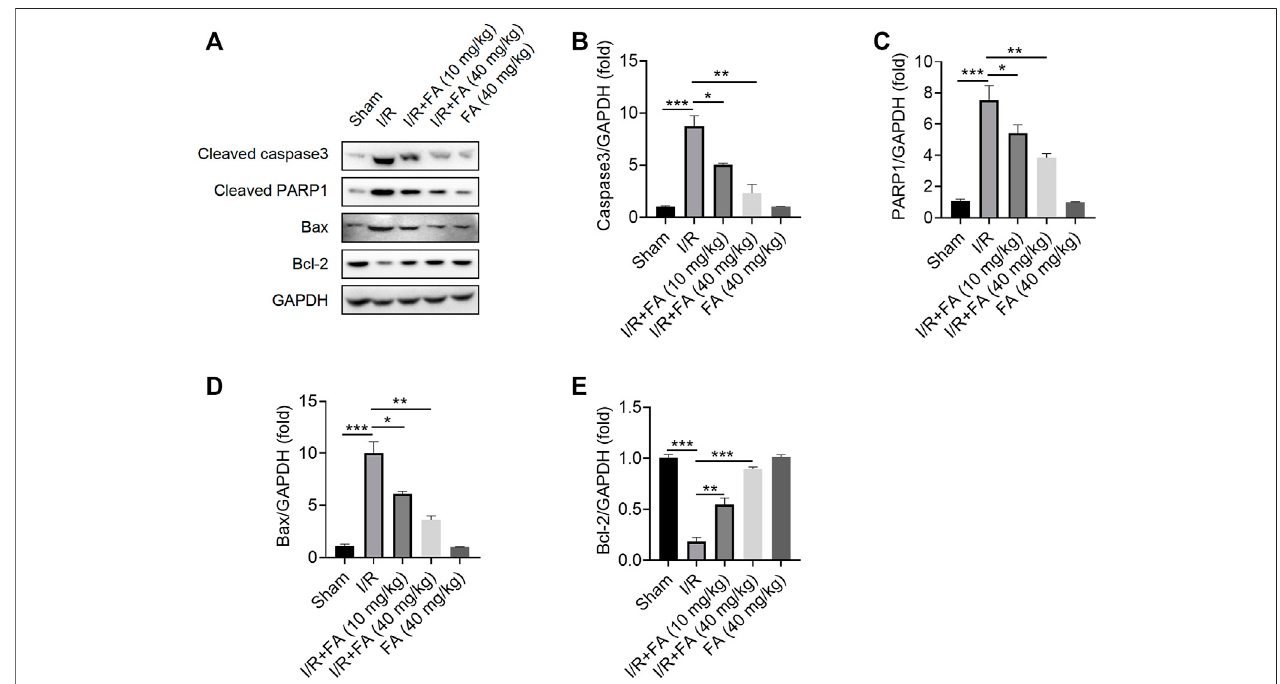
FIGURE 4 | FA inhibits I/R-induced apoptosis in mice. (A – E) Western blotting detection of the expression of the apoptosis-associated proteins cleaved PARP1, cleaved caspase-3, Bcl-2, and Bax in WT mice in each experimental group. Data are expressed as the means ± sd and are representative of three independent experiments. * p < 0.05, ** p < 0.01, and *** p < 0.001.